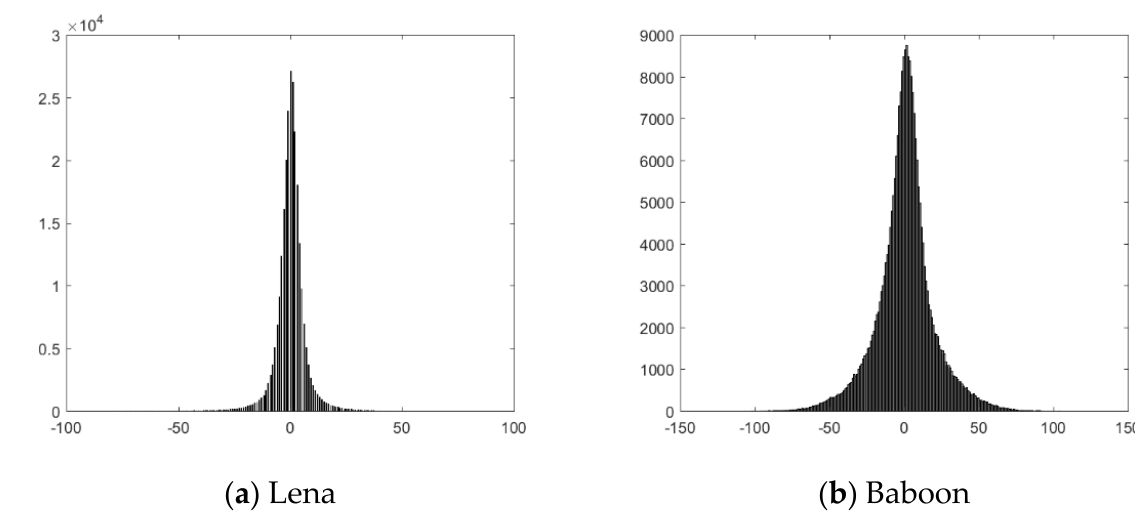
Figure 4. Prediction error histograms of Lena and Baboon .